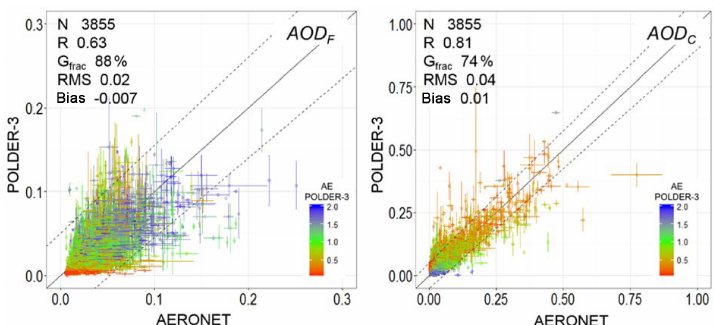
Figure 4. Scatter plots of daily AOD F and AOD C retrieved by POLDER-3 at 865nm as a function of coincident AERONET values at 870nm for the 17 sites of the western Mediterranean Sea. The solid line is the bisector. The dashed lines represent the limits indicated by the G frac parameter. The characteristics of the linear correlation (number of points N , correlation coefficient R , G frac , RMSE, and bias) are also reported. Note that, as discussed in Sect. 2.1 and 2.2, the definitions of AOD F and AOD C by POLDER-3 and AERONET are not the same.